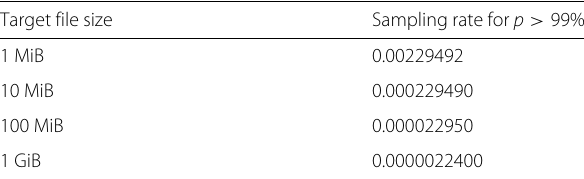
Table 7 Sampling rate for each file size